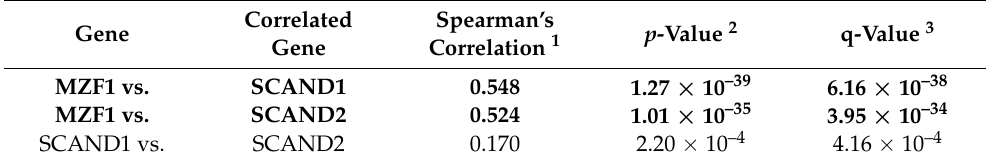
Figure 4. Co-expression correlation between MZF1 , SCAND1 , and SCAND2 in prostate cancer. ( A ) SCAND1 vs. MZF1, ( B ) SCAND2 vs. MZF1, ( C ) SCAND1 vs. SCAND2 in prostate adenocarci- noma specimens derived from patients (494 samples, TCGA PanCancer Atlas). Table 3. Co-expression correlation between HSFs , MZF1 , and SCANDs in prostate adenocarcinomas. Correlated Spearman’s